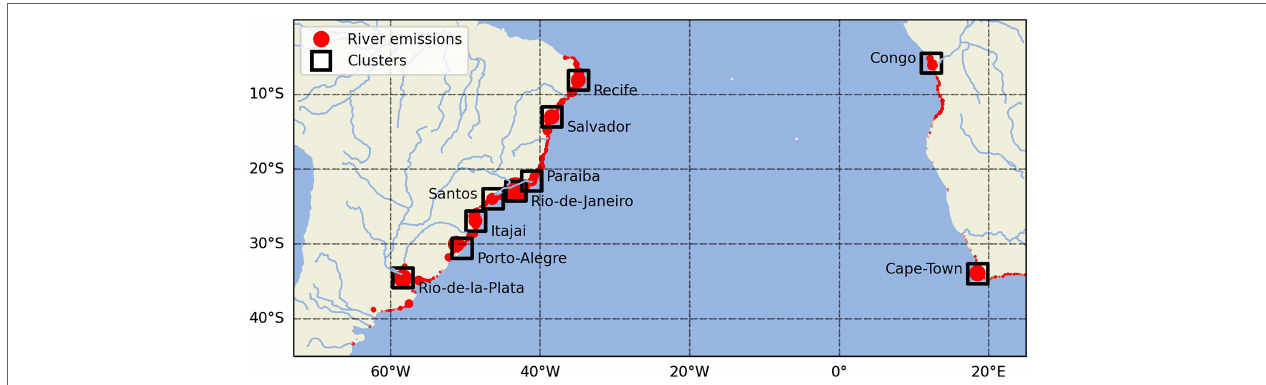
FIGURE 1 | Map of the top plastic-emitting rivers (red dots) in the South Atlantic from Meijer et al. (2021) and the clusters (black squares) used as sources in this study. The size of the red circles is proportional to the rivers’ plastic emission. The size of the black squares exaggerates the true size of the clusters, which is 2° by 2°. The dots that fall outside the clusters represent the position for the river mouths of unclustered rivers on the American and African